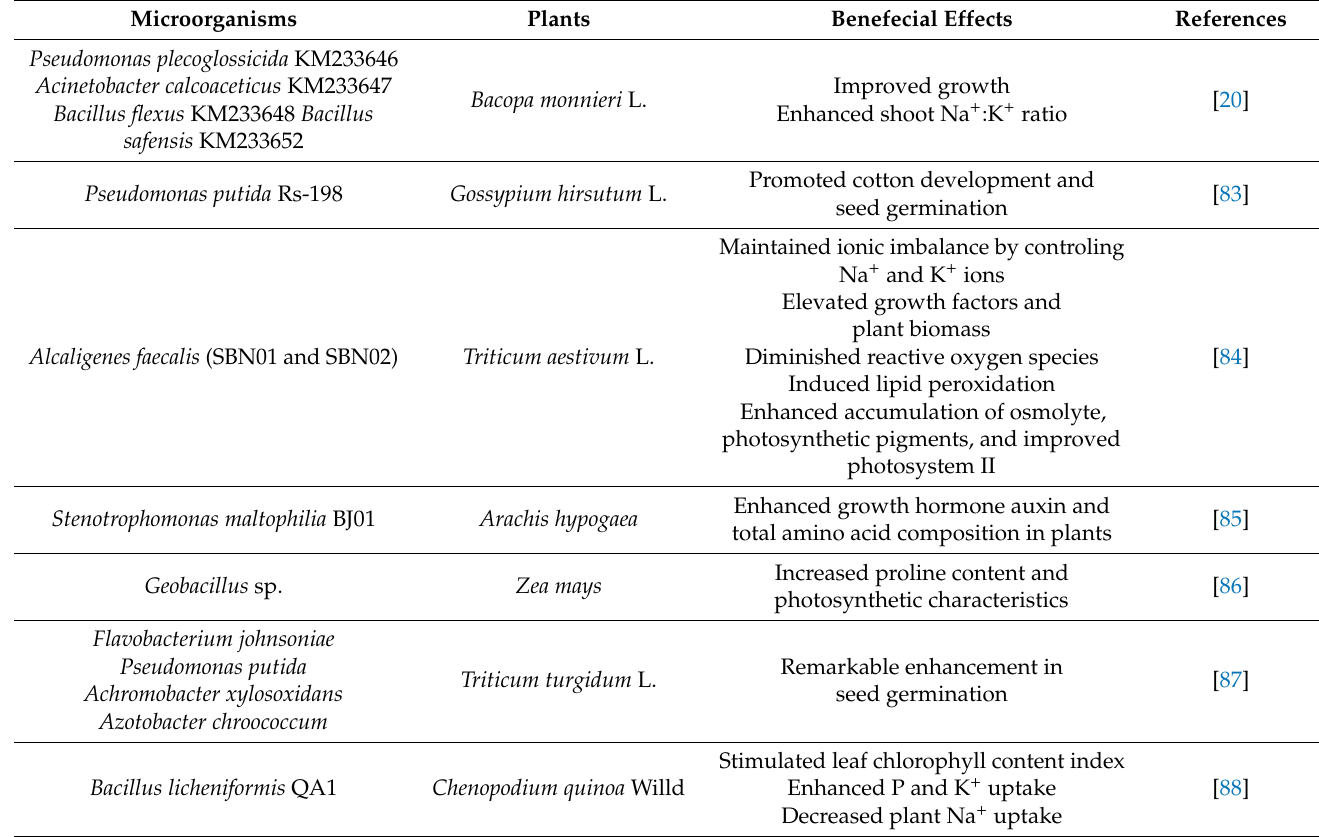
Table 1. Halotolerant microorganisms and their beneficial effects on plant growth under saline